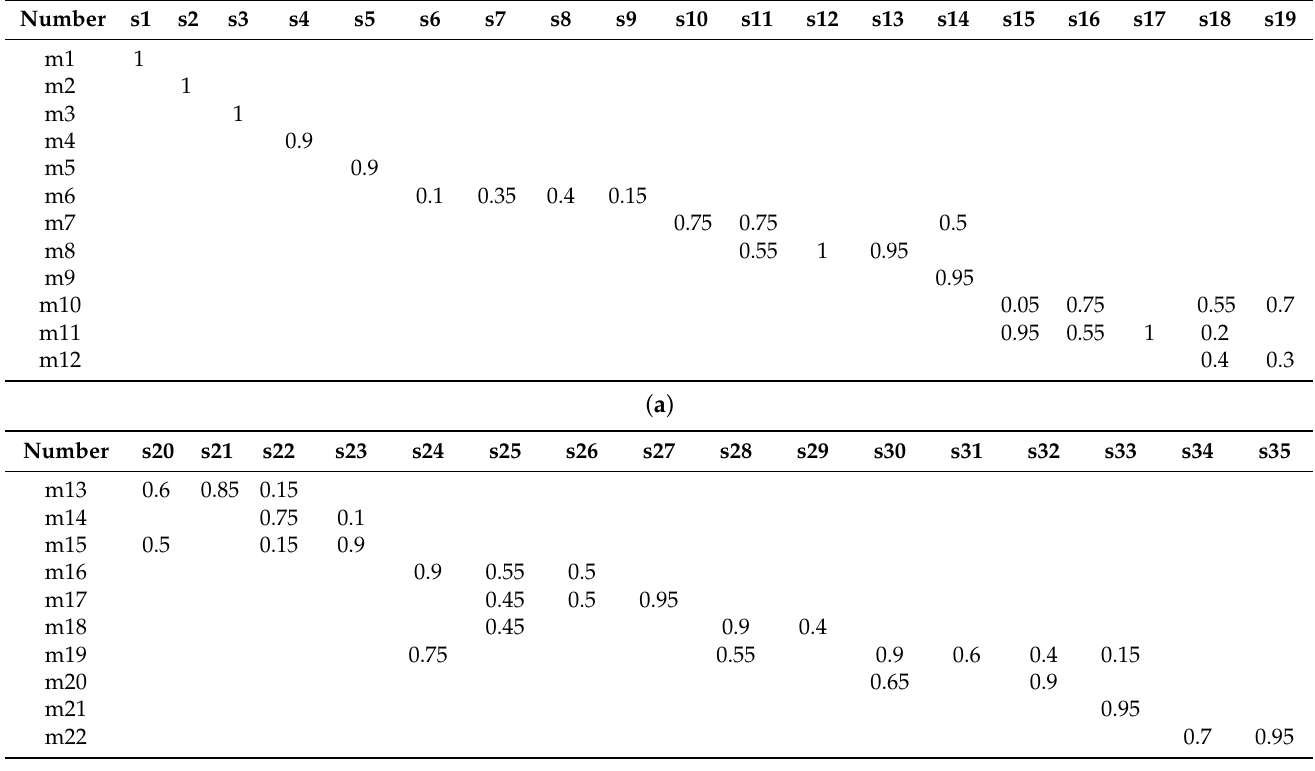
Table A1. ( a , b ) The incidence relation of failure causes and failure